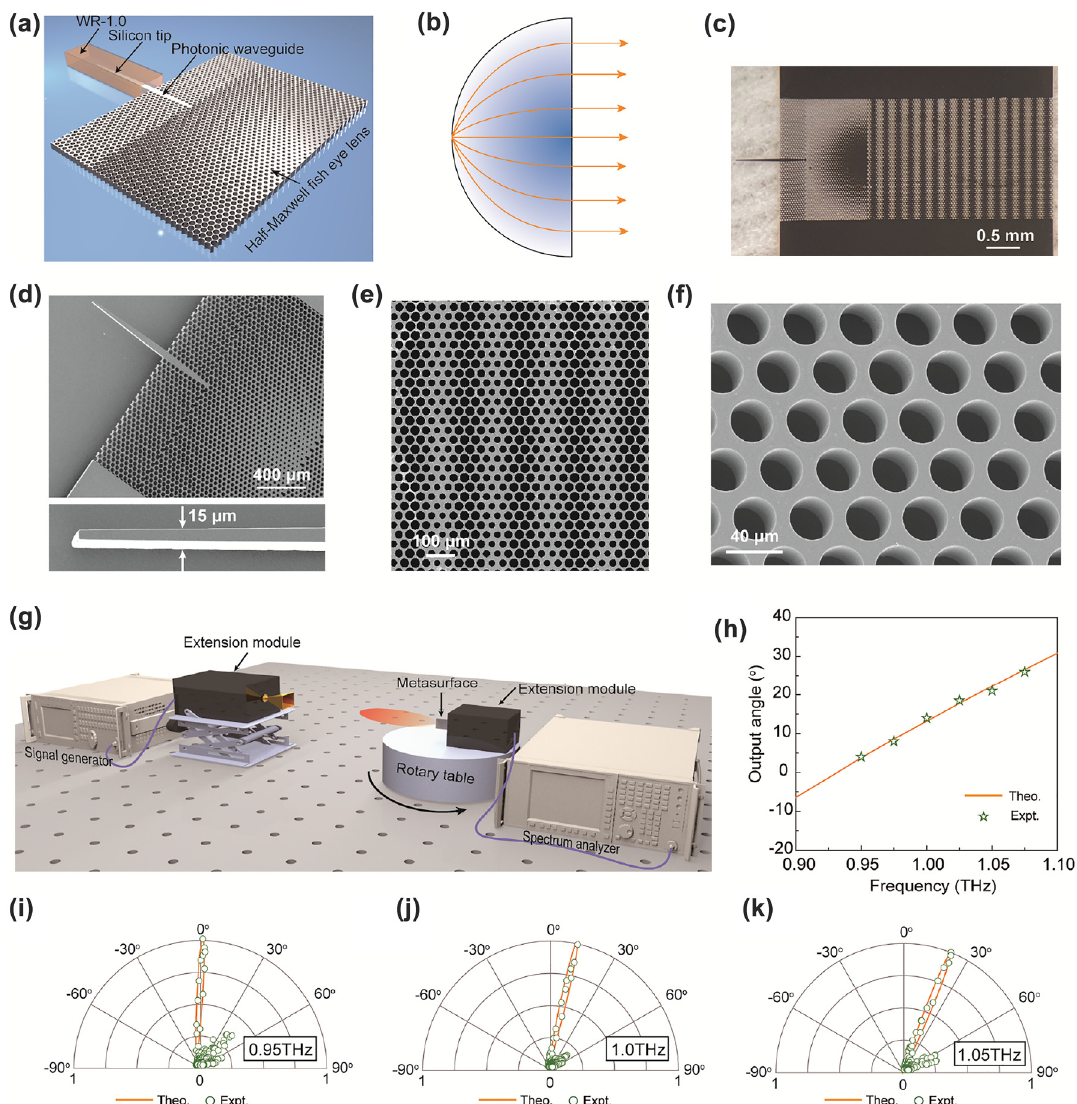
Figure 6: Prototype fabrication and characterization. (a) Schematic of the off-chip measurement of the superheterodyne metasurface. A Si taper tip, a photonic waveguide, and a planar half-Maxwell fisheye lens are utilized to feed the superheterodyne metasurface. The silicon tip is inserted into a standard WR-1.0 waveguide to couple the energy. (b) Working principle of the planar half-Maxwell fish eye lens that generates collimated guided waves to feed the superheterodyne metasurface. (c) Photo of the fabricated prototype. (d to f) Scanning electron micrographs of the silicon tip and half-Maxwell fish eye lens, superheterodyne metasurface, and 2D lattice of air hole of the Si slab, respectively. (g) THz measurement setup to characterize the scattering patterns of the superheterodyne metasurface. (h) Experimental and theoretical output angles of the superheterodyne metasurface at different frequencies. (i to k) Experimental and theoretical scattering patterns at 0.95, 1.0, and 1.05 THz,